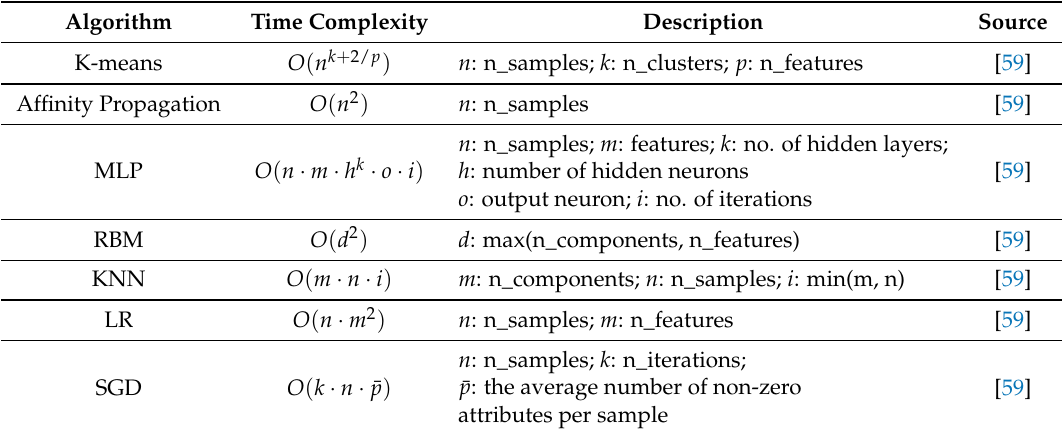
Table 3. Time Complexities of Models used in the